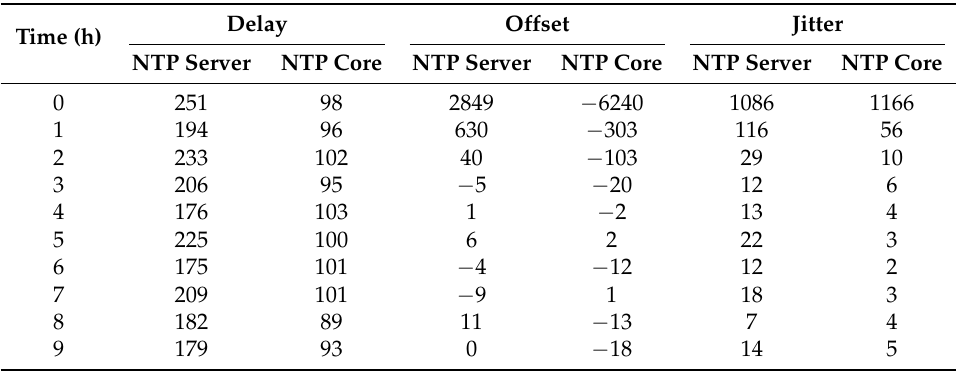
Table 8. Delay, offset and jitter evolution with time ( µ